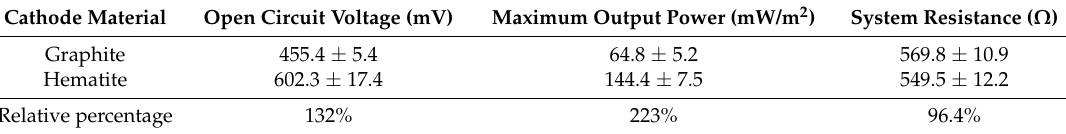
Table 1. The average electrical parameters of electron transfer in reaction systems.